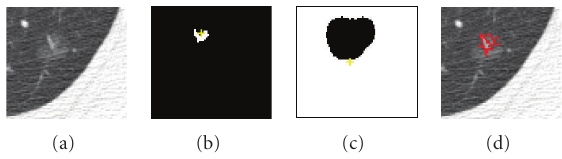
Figure 21: Segmentation results on a GGO nodule; (a) one slice of the GGO nodule; (b) initial foreground seeds located on the top border of the nodule; (c) initial background; (d) segmented nodule which is missing parts of the opacified